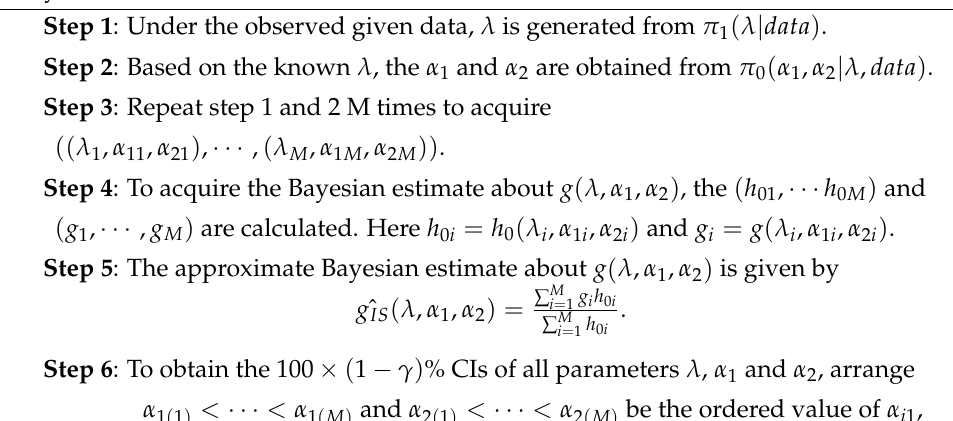
Algorithm A2: The application of the importance sampling technique in Bayesian estimates and HPD credible intervals for unknown λ